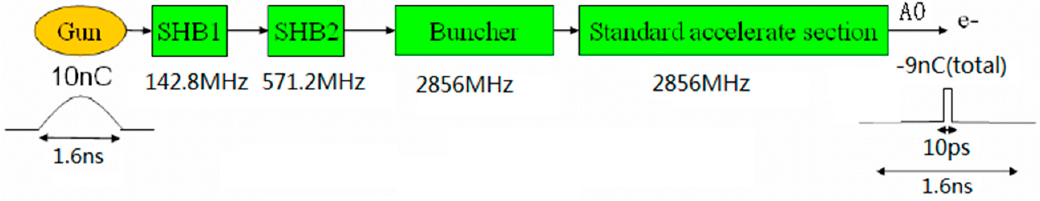
Figure 1. Schematic of the